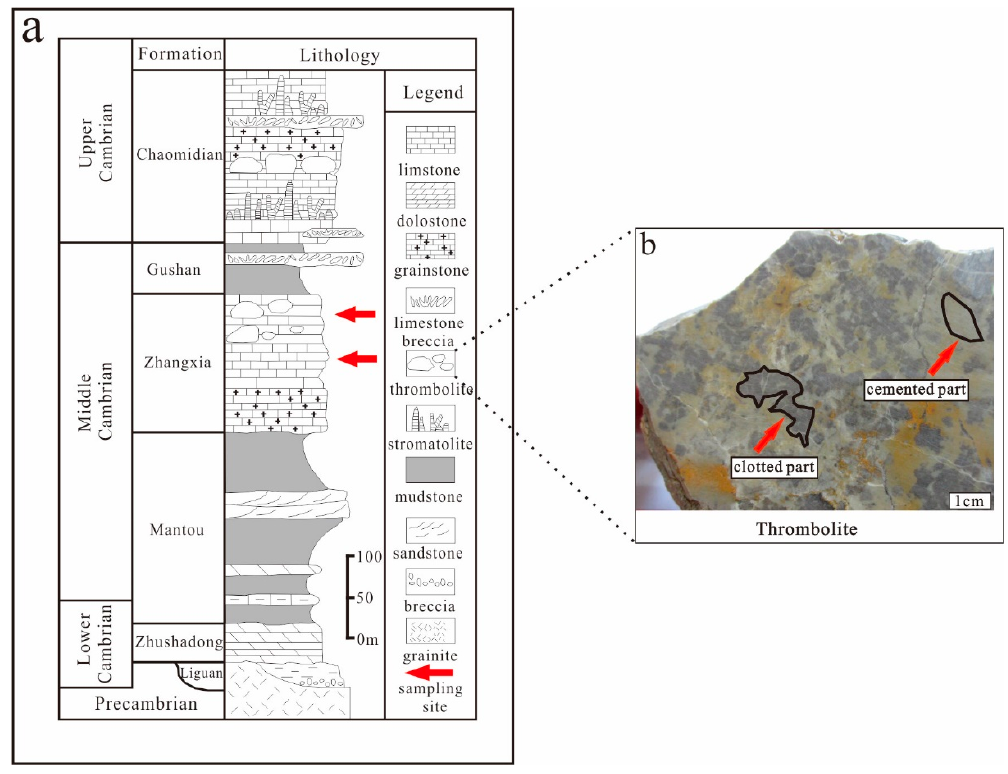
Figure 1. ( a ) Cambrian chronostratigraphy, lithostratigraphy in western Shandong; ( b ) sampling locations of cemented and clotted parts in thrombolite.